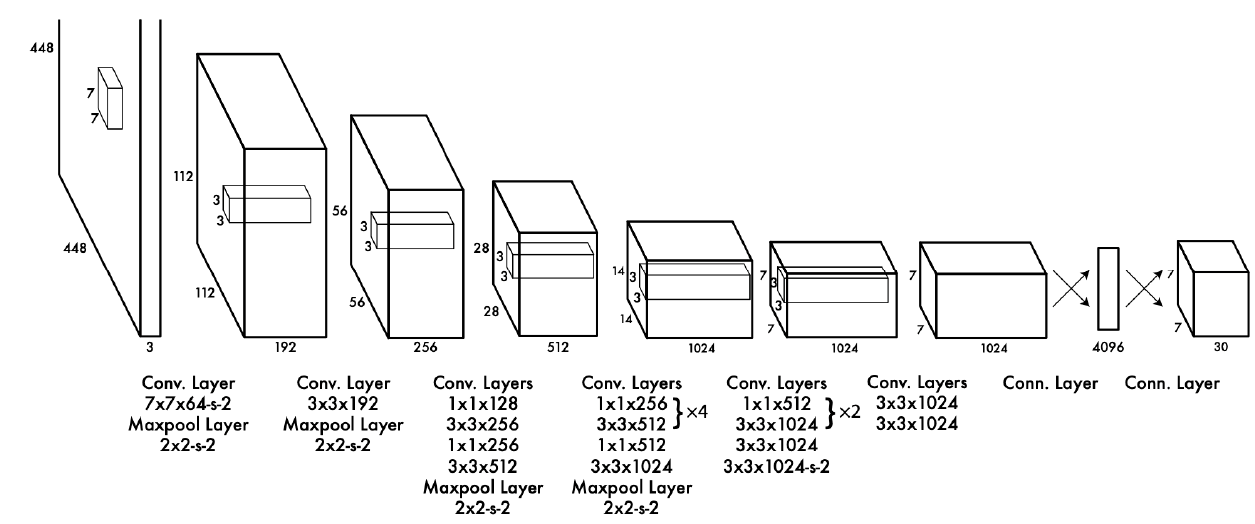
Figure 2. YOLO network architecture [29].